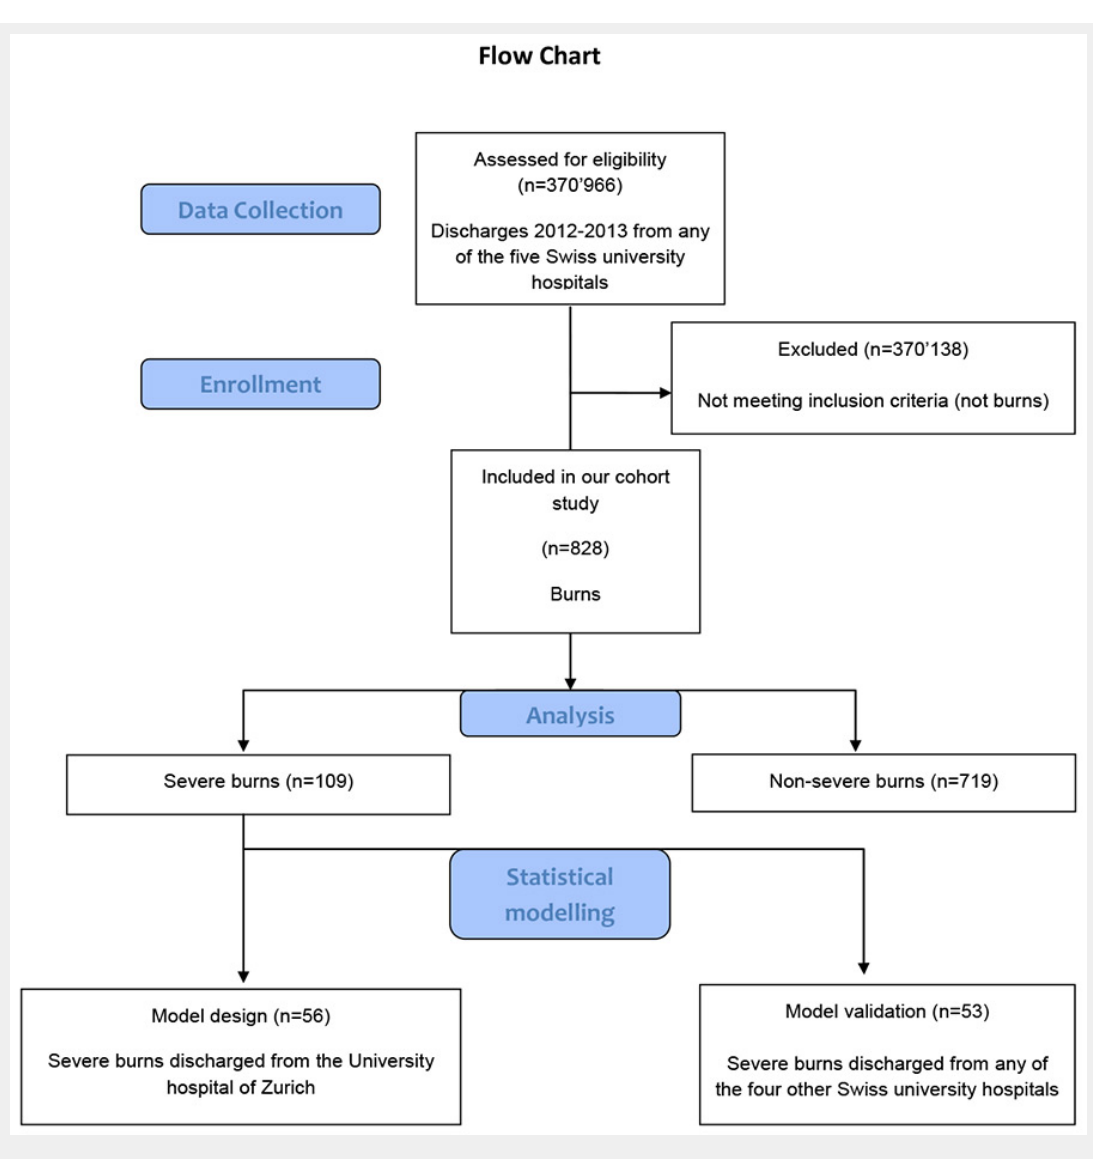
Figure 1 Flow-chart of the study design and